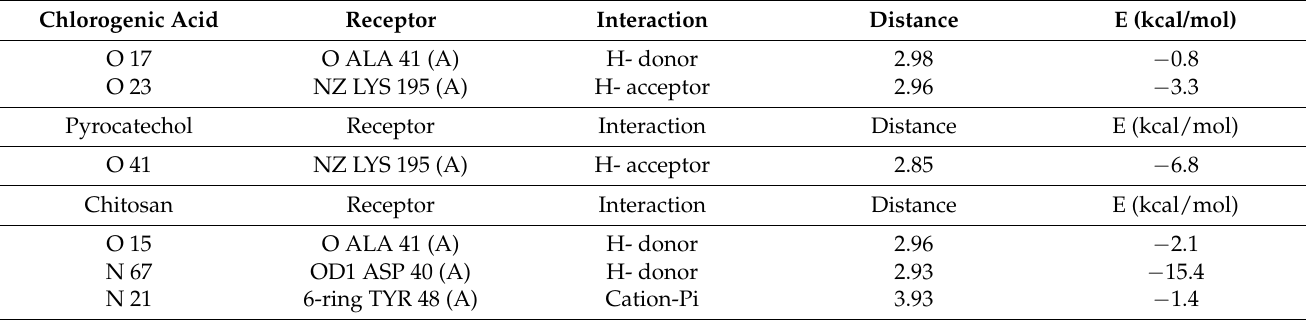
Table 6. Interaction of chlorogenic acid, pyrocatechol, and chitosan with 4HI0